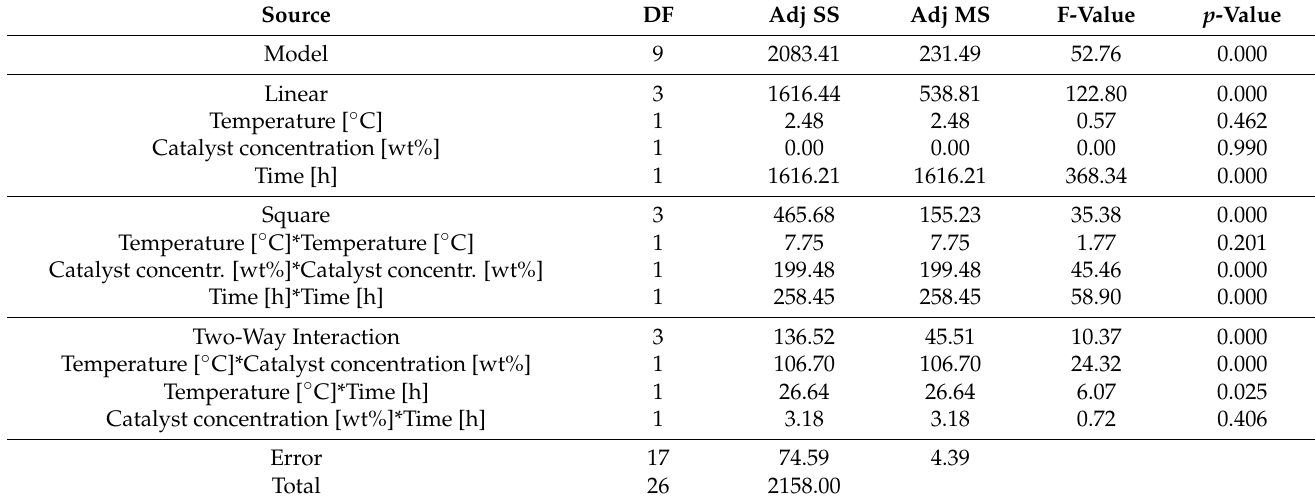
Table 6. Analysis of variance of CL